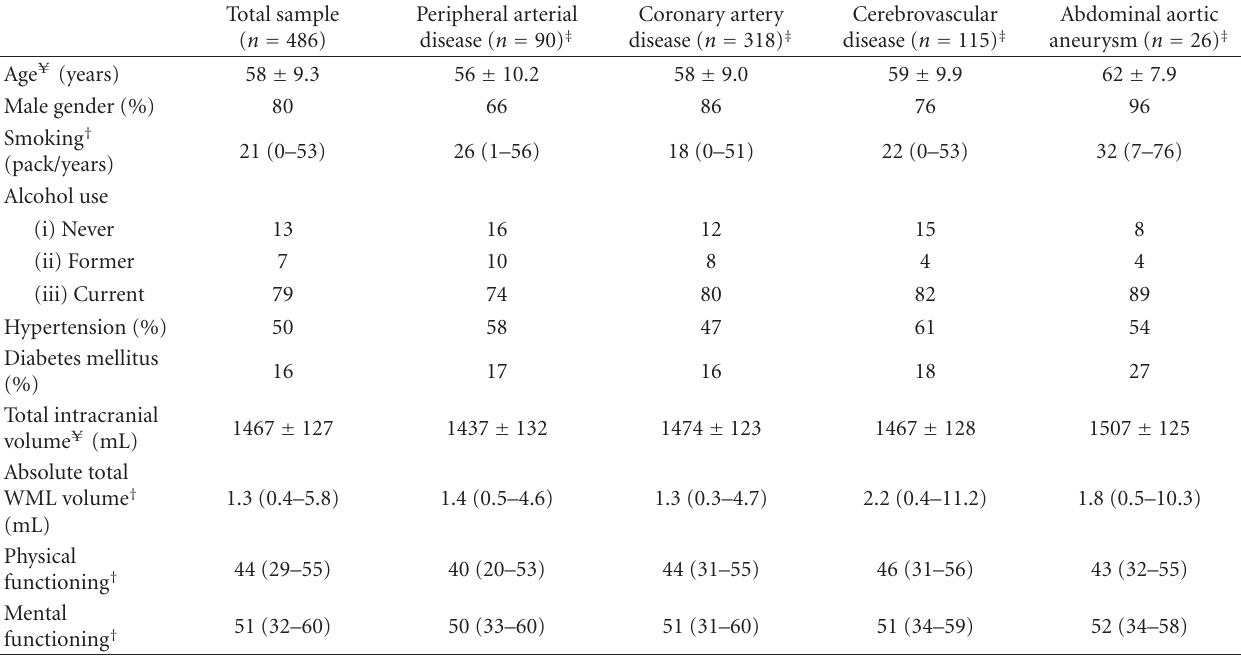
Table 2: Baseline